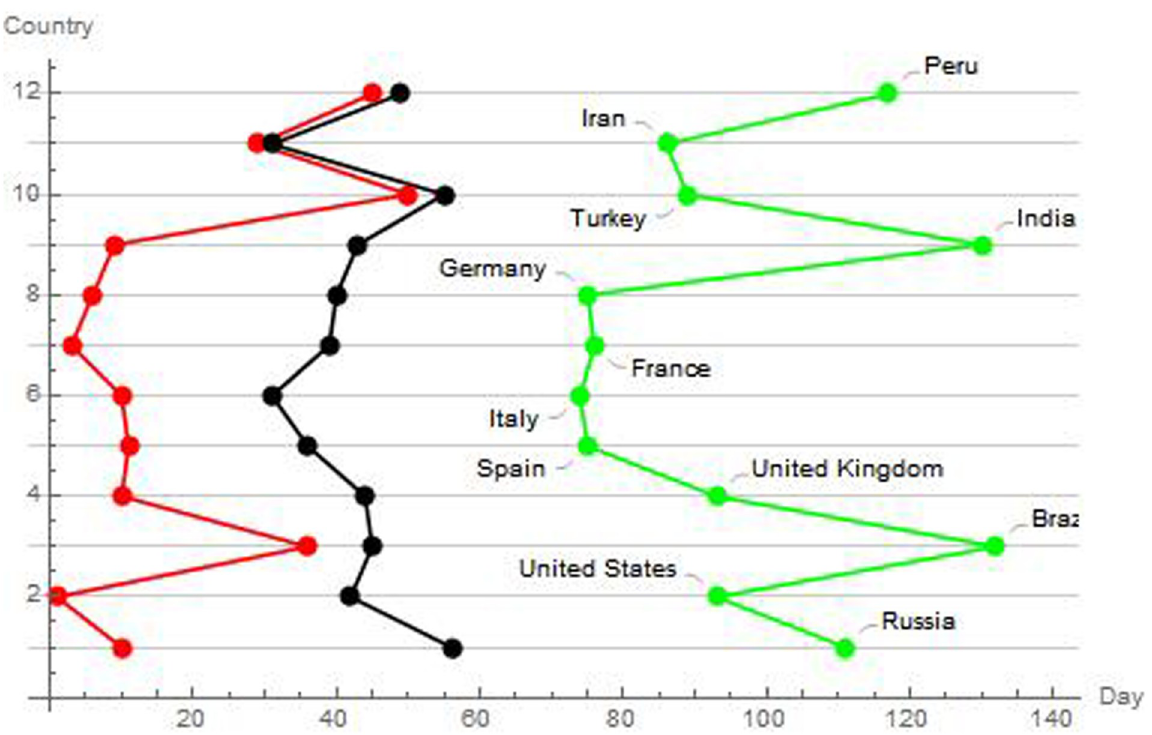
Fig 8. Trends of the rhythms of evolution for the starting dates (red), hot spot expansion dates (black) and turning points of the pandemic dates (green) for the 12 most affected countries. The image has been obtained by considering the intervals among these observation points, and by sketching on a plane the differences, obtaining the temporal intervals of the pandemic course. In analogy with physical systems, we have called these intervals as phase changes in the pandemic trend.